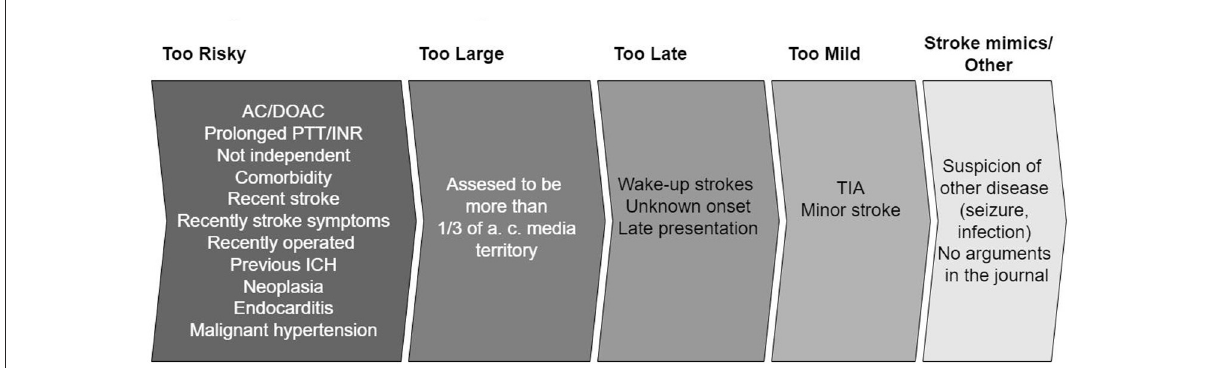
FIGURE1 Arguments grouped into five categories. When there is more than one argument, the most important is prioritized in the following order: “Too risky,” “to large,” “too late,” “too mild,” “stroke mimics/other.” A more detailed version of the arguments exists in Appendix Table 1. AC, anticoagulants; DOAC, direct acting oral anticoagulants; PTT, partial thromboplastin time; INR, internationalized normalized ratio; ICH, intracranial hemorrhage; TIA, transitory ischemic attack.